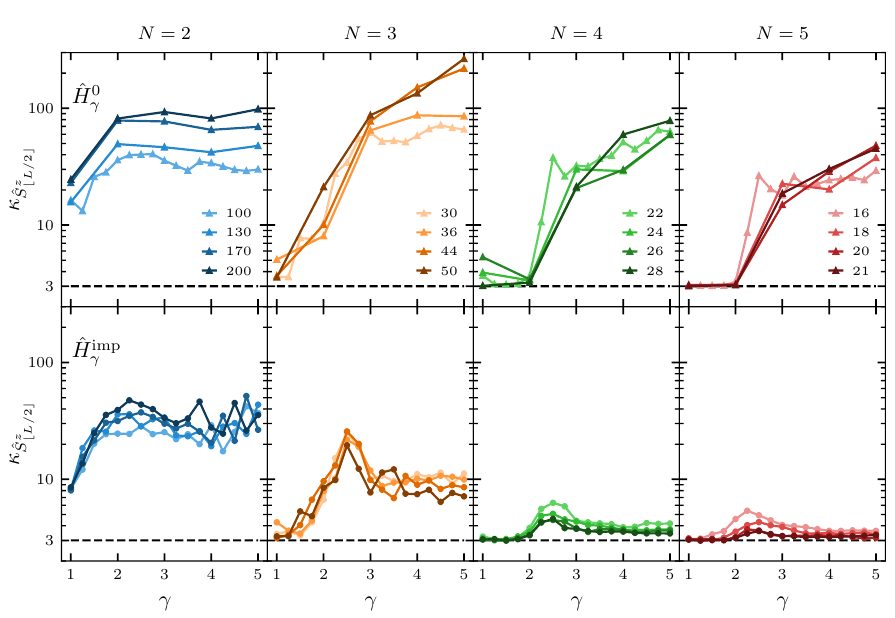
Figure 4: Kurtosis of the distribution of off-diagonal matrix elements computed for 200 eigenstates in the middle of the spectrum for systems with variable ranges of interactions without the middle-site impurity, ˆ H 0 (top row), and with a middle-site γ impurity, ˆ H imp γ (bottom row), plotted for different number of excitations (different columns). In each panel, larger system sizes are represented by darker shades (see